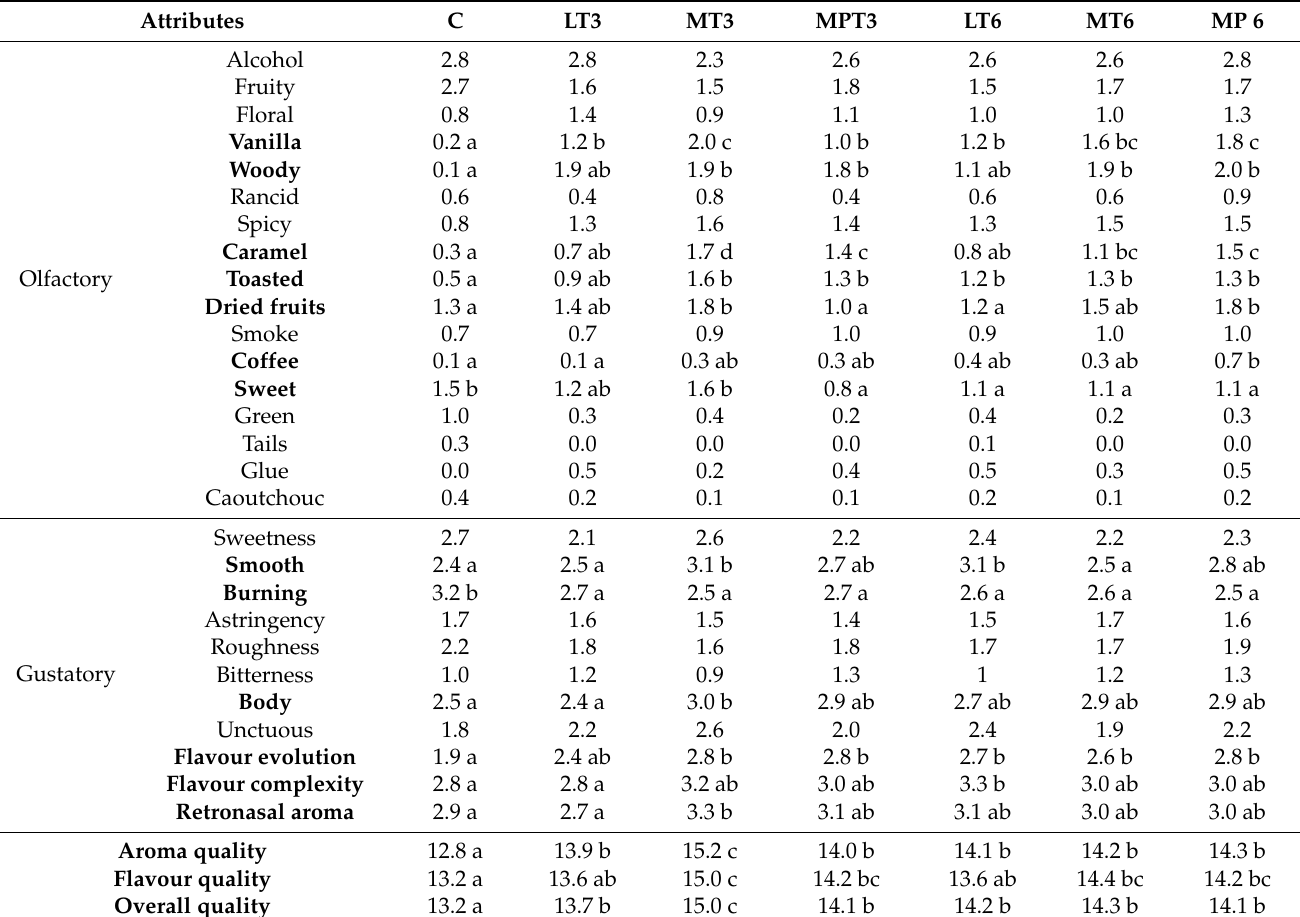
Table 4. Results of the sensory analysis of AUS regarding olfactory and gustatory